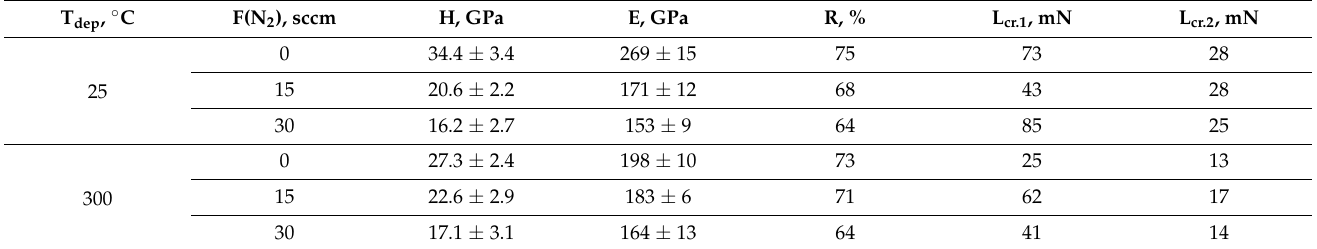
Table 9. Mechanical properties of SiC x N y films using nanoindentation measurements (series A and C).